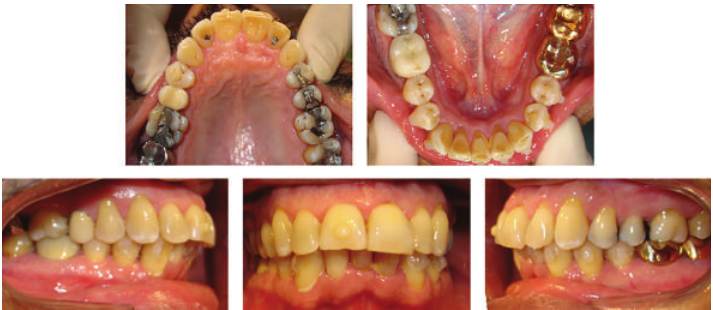
Figure 3: Progress intraoral composite photographs showing the bonded attachments.